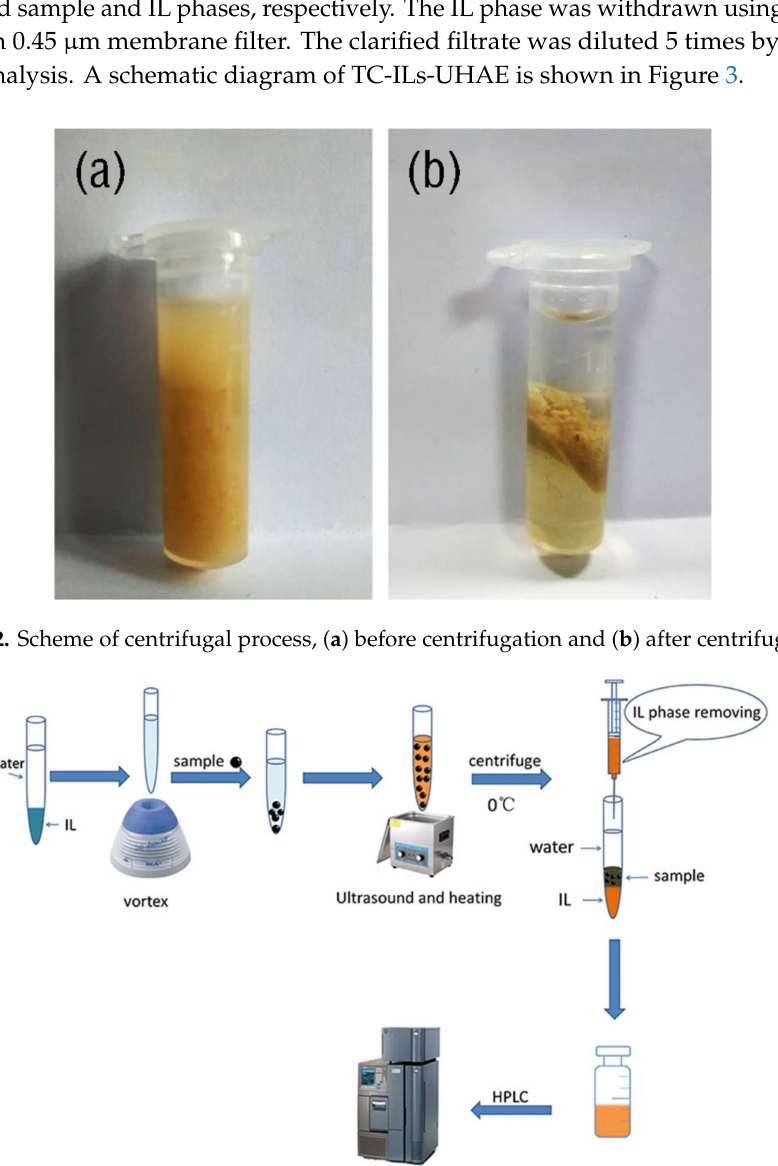
Figure 3. Schematic diagram of temperature-controlled hydrophobic ionic liquids-based ultrasound / heating-assisted extraction (TC-ILs-UHAE)